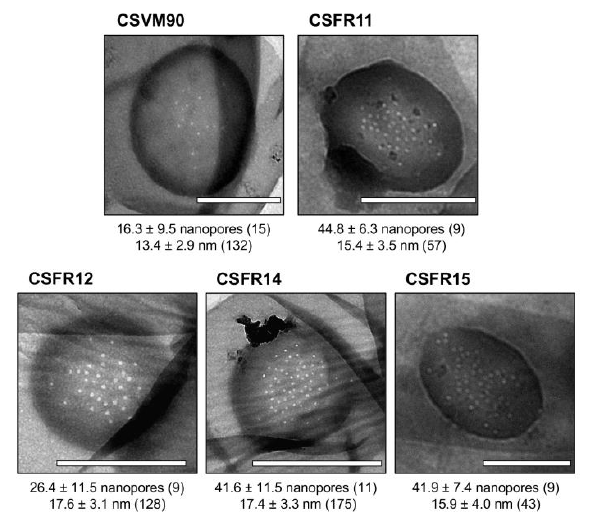
FIGURE 6: Nanopores in septal peptidoglycan disks of the indi- cated Anabaena strains. Quantification of nanopores (mean ± SD; number of disks quantified in parenthesis) and nanopore diame- ter (mean ± SD; number of nanopores measured in parenthesis) are indicated below each micrograph. Scale bars, 1